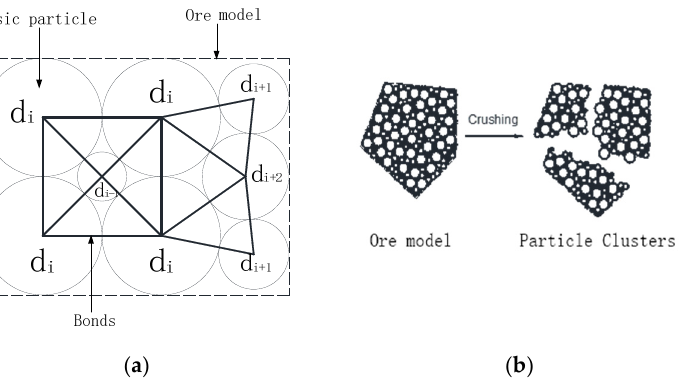
Figure 1. Structure and the crushing process of BPM. ( a ) Structure of the BPM; ( b ) Crushing process of